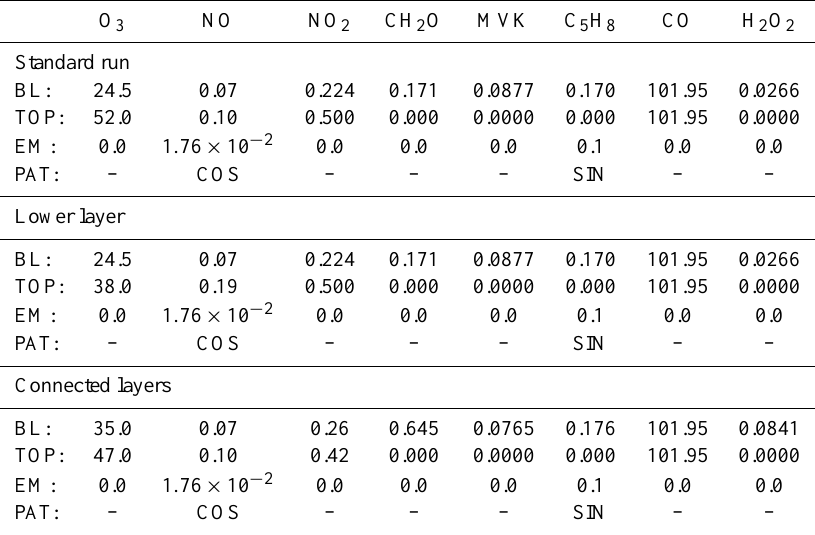
Table 7. The prescribed initial mixing ratios (ppbv) and the emissions at the surface (mgm − 2 h − 1 ) of the reactive species for the numerical experiments discussed in Sect. 3.4. The conversion factors for the NO and C 5 H 8 emissions from ppbvms − 1 to mgm − 2 h − 1 are 4.4 and 10, respectively. The initial conditions are listed for the boundary layer, BL, and the atmospheric layer aloft, TOP. Maximum emissions are denoted by EM and emission patterns by PAT. COS corresponds to an emission of EM (cid:16) (cid:17) EMsin 2 π t − 4 . Not listed are the values for species without emissions and zero initial mixing ratio and those for CH 4 , O 2 and N 2 . These 18 latter three species have constant mixing ratios of 1759, 2 × 10 8 and 8 × 10 8 ppbv,